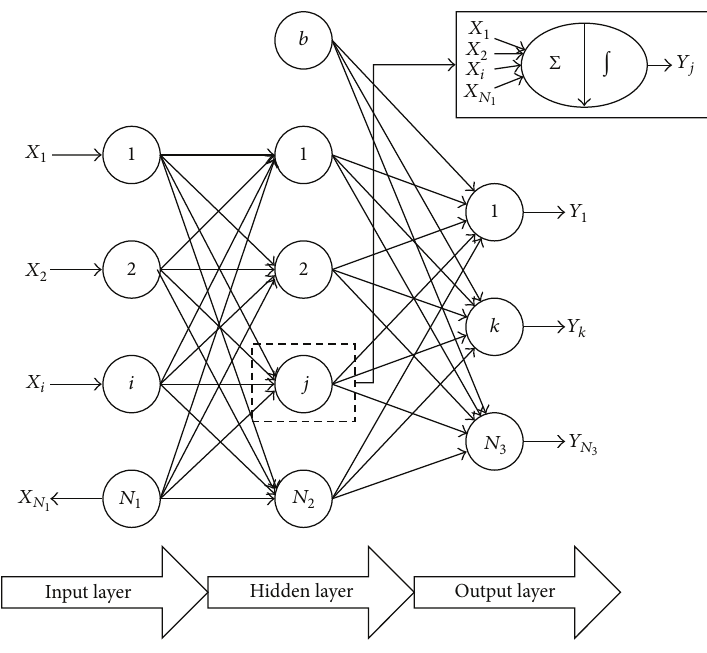
Figure 6: Structure of a